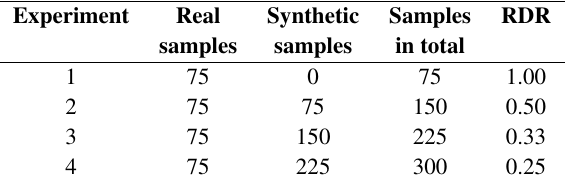
Table 1. Data distribution within 4 different experiments